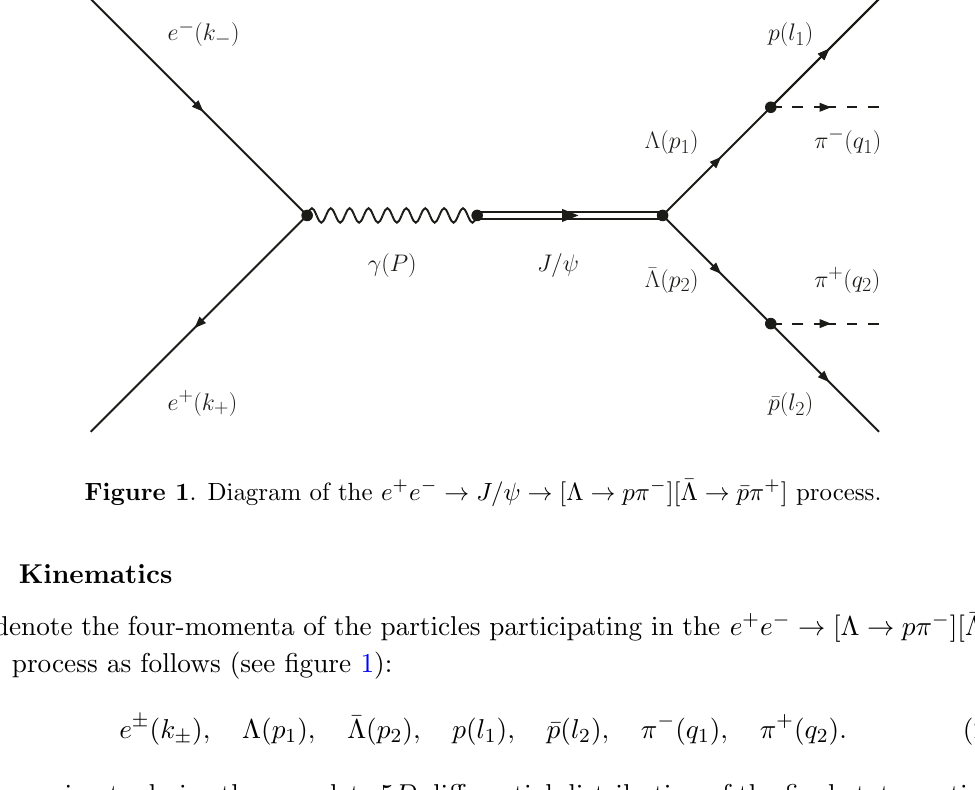
(cid:22) p(cid:25) + ] !